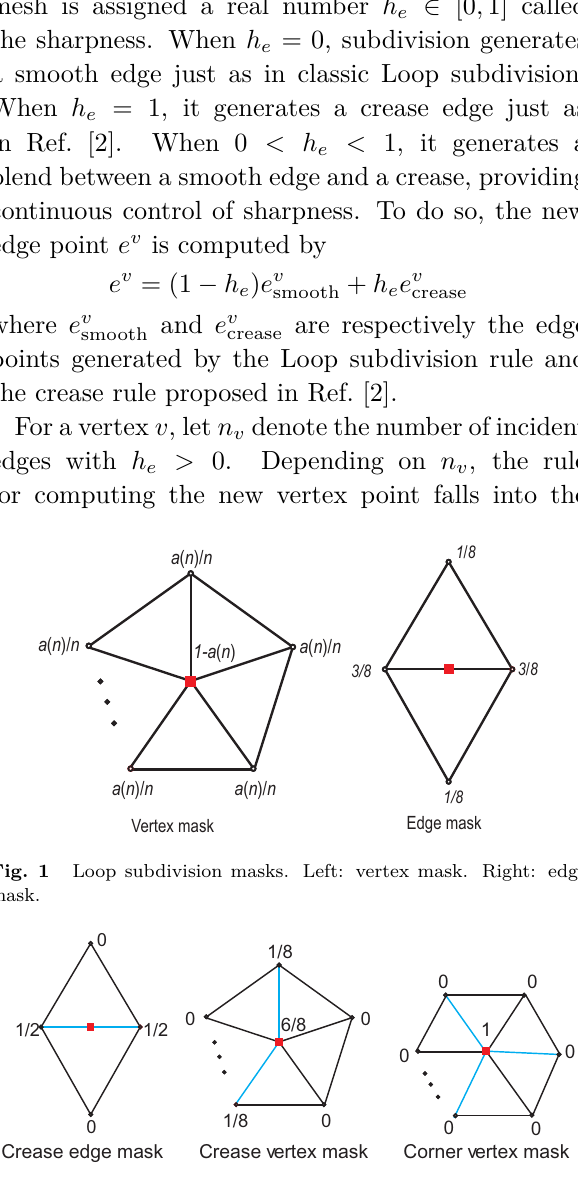
Fig. 2 Sharp feature masks. Blue lines are sharp edges. The red rectangle is the new inserted